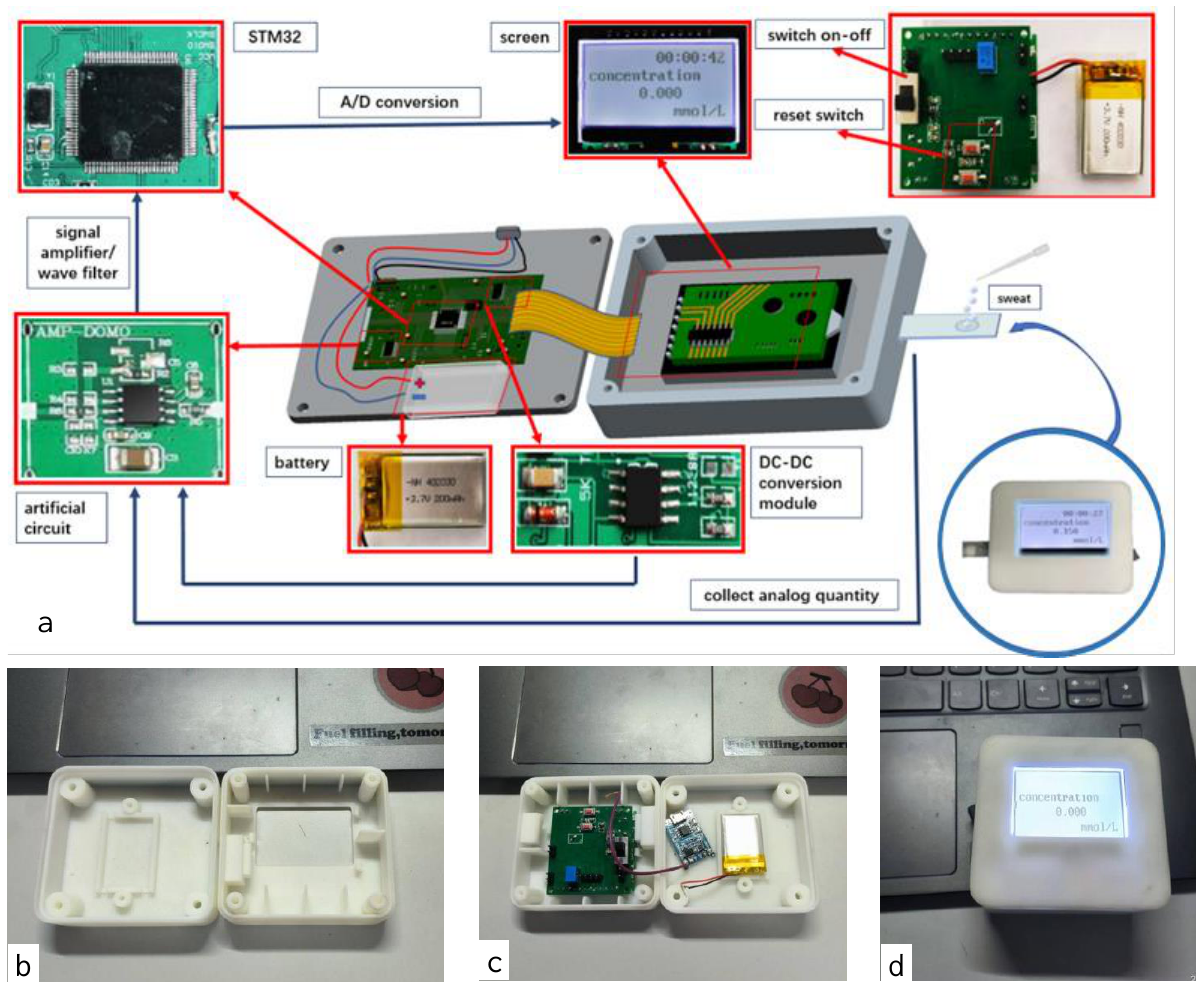
Figure 3. The portable sweat detection device: ( a ) internal structure diagram. ( b ) 3D printing shell. ( c ) real internal photo. ( d ) real detection device photo.